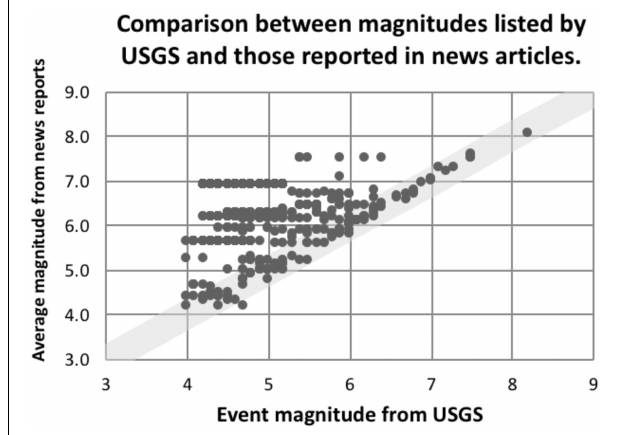
FIGURE 6 | Comparison between magnitudes published by USGS and the average of magnitudes reported by different agencies. The thick gray line represents the expected 1-to-1